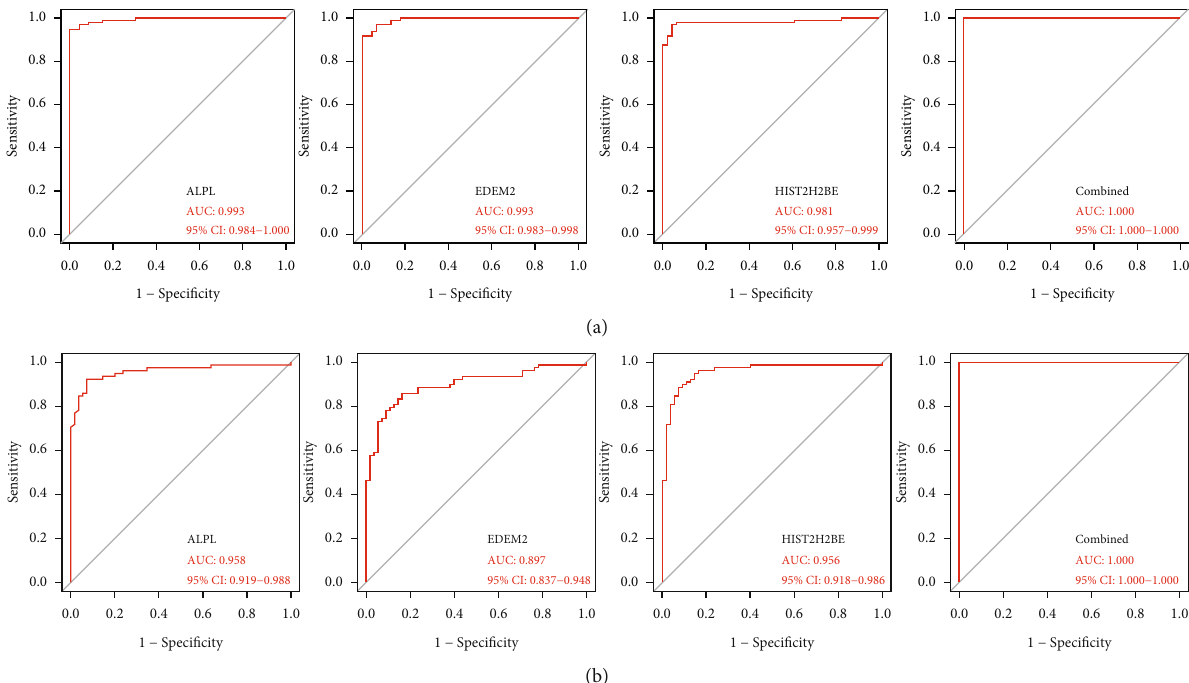
Figure 5: The receiver operating characteristic (ROC) curve of the diagnostic e ff ectiveness of the three diagnostic markers. (a) ROC curve of ALPL, EDEM2, and HIST2H2BE after fi tting to one variable in the metadata cohort. (b) ROC curve of ALPL, EDEM2, and HIST2H2BE after fi tting to one variable in the GSE73461